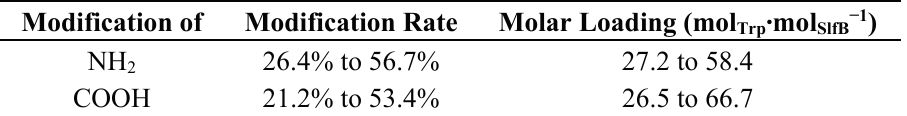
Table 2. Total amount of modified COOH and NH 2 -groups with